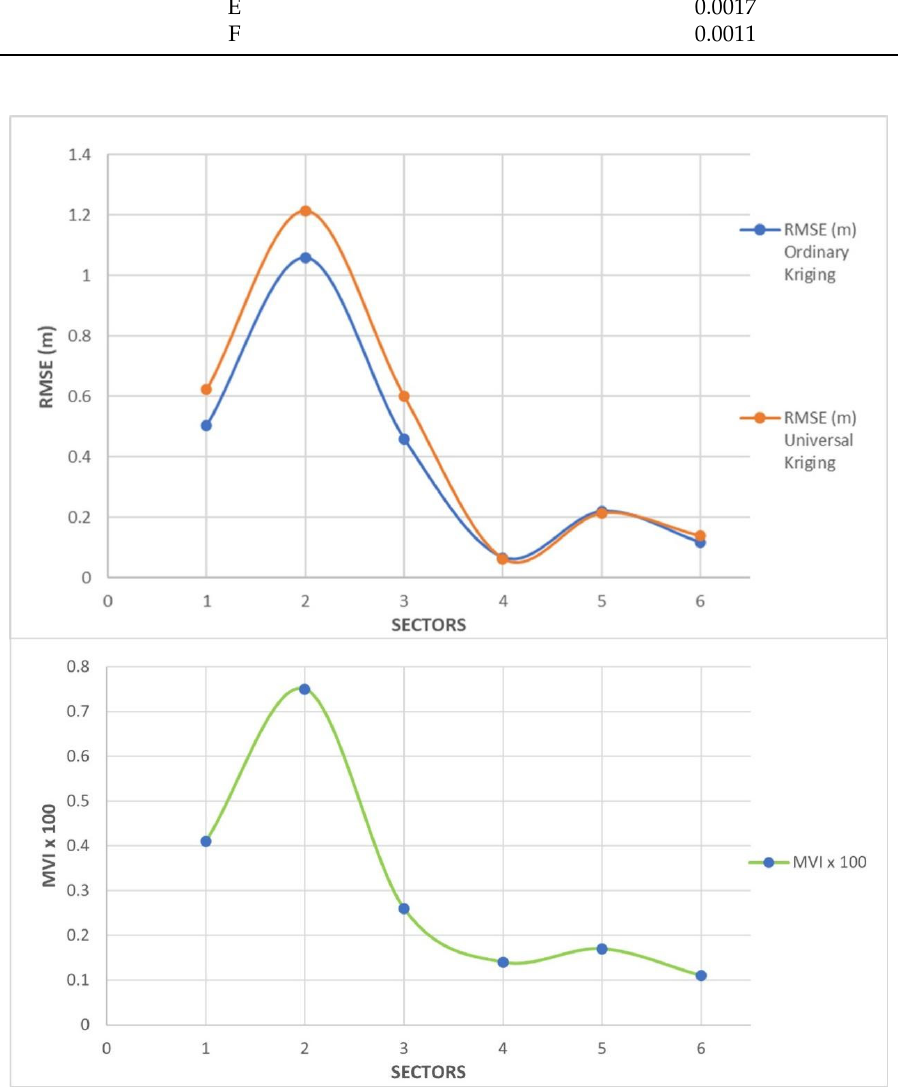
Figure 12. RMSE values in the case of 2400 points using Ordinary Kriging and Universal Kriging for each sector ( upper ) and MVI values calculated in the six sectors ( lower ).